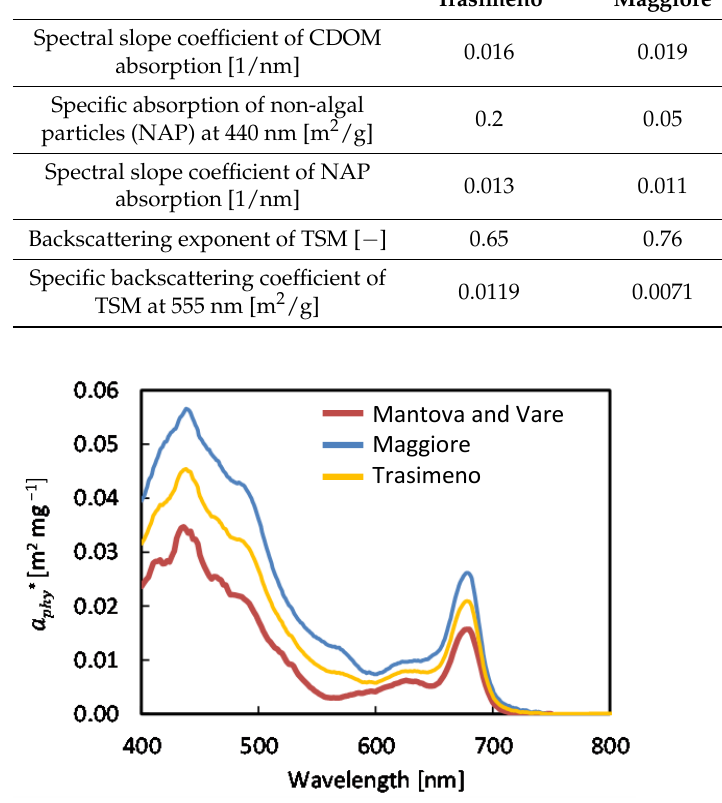
( λ ) in Italian phy